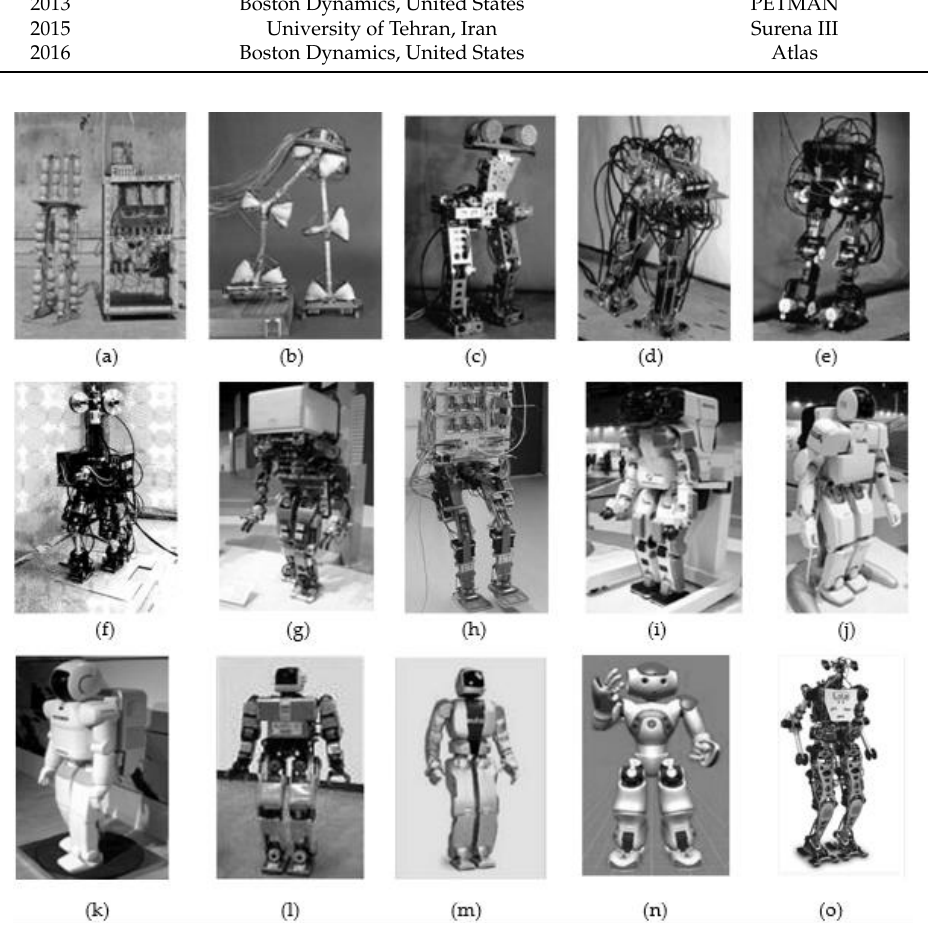
Figure 1. The historical development of bipedal robots. ( a ) WAP-1; ( b ) WAP-3; ( c ) WL-5; ( d ) WL-9DR; ( e ) WL-10RD; ( f ) WL-12; ( g ) Honda P-1; ( h ) BIP2000; ( i ) Honda P-2; ( j ) Honda P-3; ( k ) ASIMO; ( l ) KHR-2; ( m ) HUBO; ( n ) NAO; ( o ) LOLA. (( a – e , g , i – m ) were reproduced with permission from [36]; ( f ) was reproduced with permission from [37], Copyright Springer, 1997; ( h ) was reproduced with